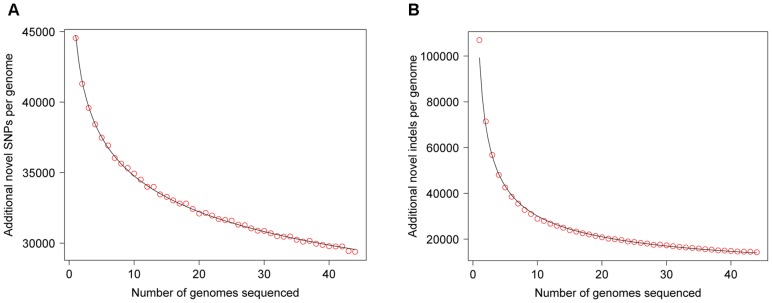
The number of novel SNPs and indels discovered as the number of sequenced genomes increased.We evaluated how many additional “new” A) SNPs and B) indels, respectively, were identified per genome as the number of sequenced genomes increased, considering both variants archived in databases (dbSNP v131 and the 1000 Genome Project Phase 1 data) and variants “discovered” in previously considered genomes. The 44 genomes were added into the analyses in a random order. With 1000 permutations, the average numbers of novel variants added per genome are shown, along with the best fitting trendline for each plot.